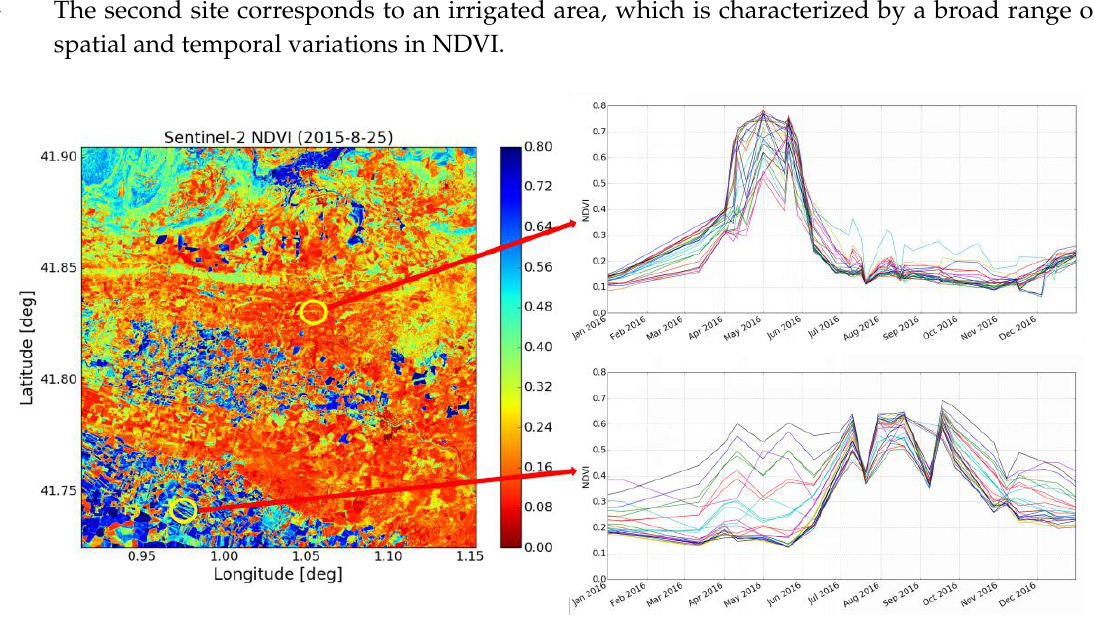
Figure 2. Sentinel-2 NDVI map in the study area ( left ), NDVI time series for the dry land site ( upper right ), and NDVI time series for the site in the old irrigated area ( lower right ).